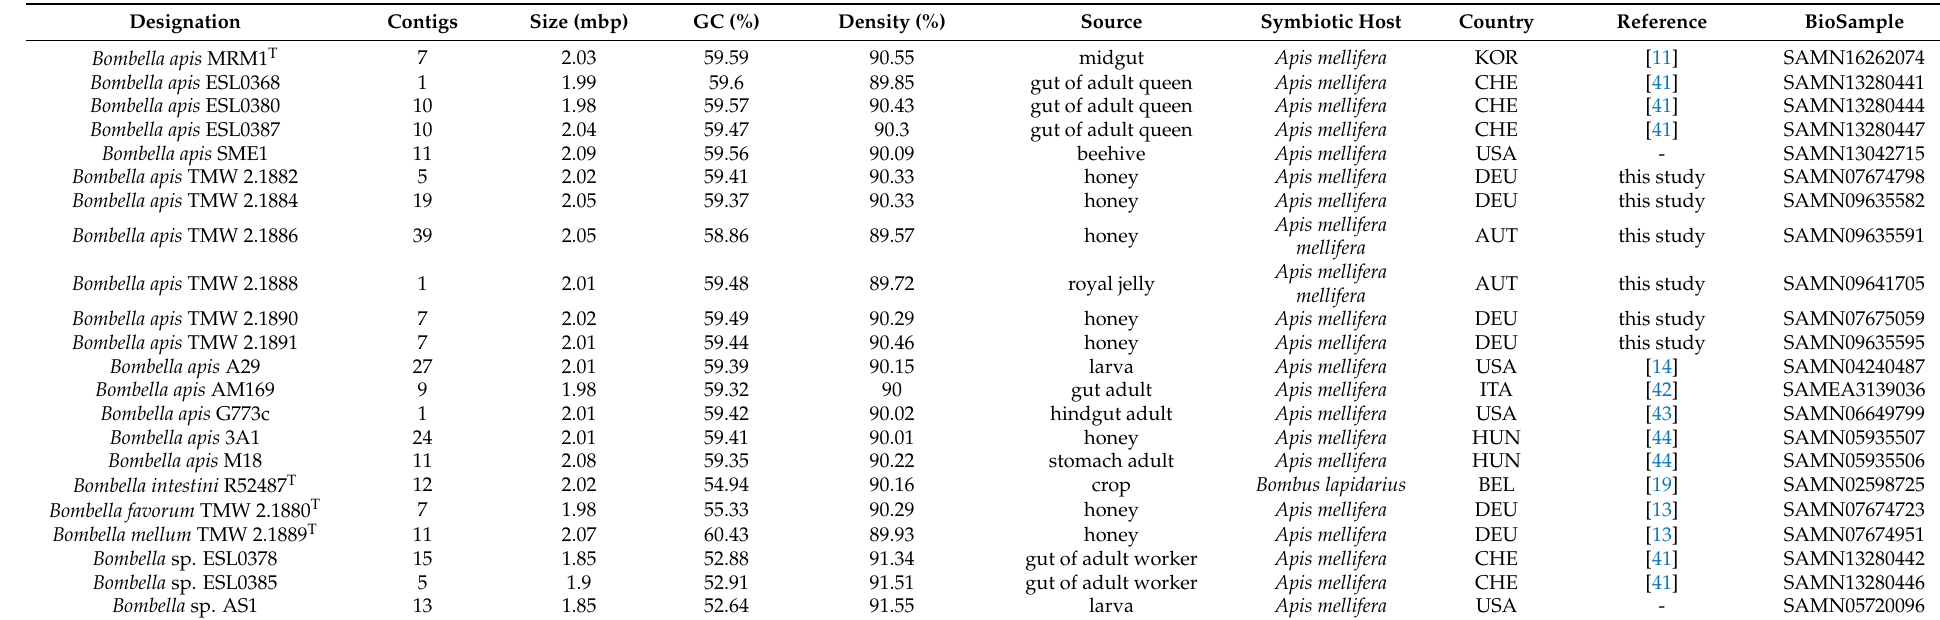
Table 1. Characteristics, origin and isolation source of available Bombella genomes within the NCBI